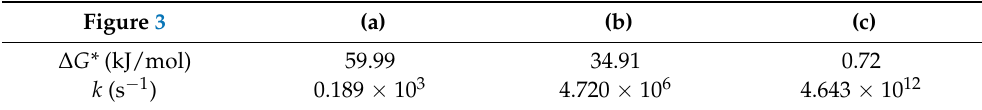
Table 4. Activation energy ( ∆ G* ) and dissolution rate ( k ) computations of light gray Ca dissolution from 110 or 110 facets at the room temperature according to Figure